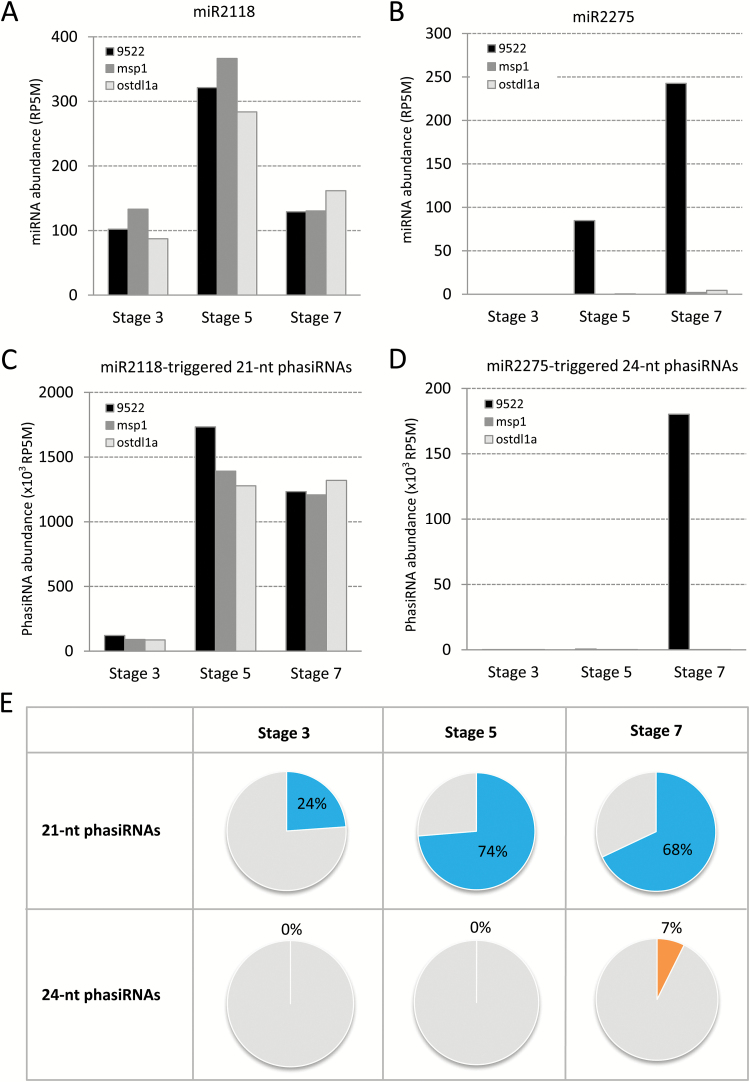
miR2118, miR2275, and phasiRNA abundances in rice spikelets. Levels of miR2118 (A), miR2275 (B), miR2118-triggered 21-nt phasiRNAs (C), and miR2275-triggered 24-nt phasiRNAs (D) in different stages and backgrounds of rice spikelets. (E) The percentage of 21-nt (top, blue slices with percentage numbers) and 24-nt phasiRNAs (bottom, orange slices with percentage numbers) out of the total population of 21-nt and 24-nt genome-matched small RNAs in wild-type rice spikelets.